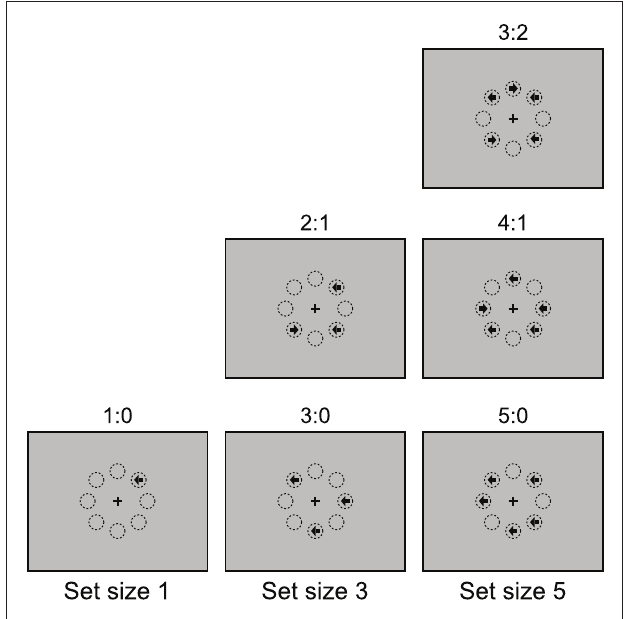
Figure 1 | The majority function task (MFT). In this task, arrows with set size 1, 3, and 5 are randomly presented at eight possible locations arranged as an octagon centered on a fixation cross. The arrows point either left or right and are presented simultaneously. The participants’ task is to indicate the direction in which the majority of arrows point. For example, if three arrows are presented, and two point to the left and one to the right (see the “2:1” panel in the “set size 3” column), the correct response should be “left”. The eight circles are for illustration of the locations and are not displayed during the experiment. Different arrow composition conditions are shown for each set